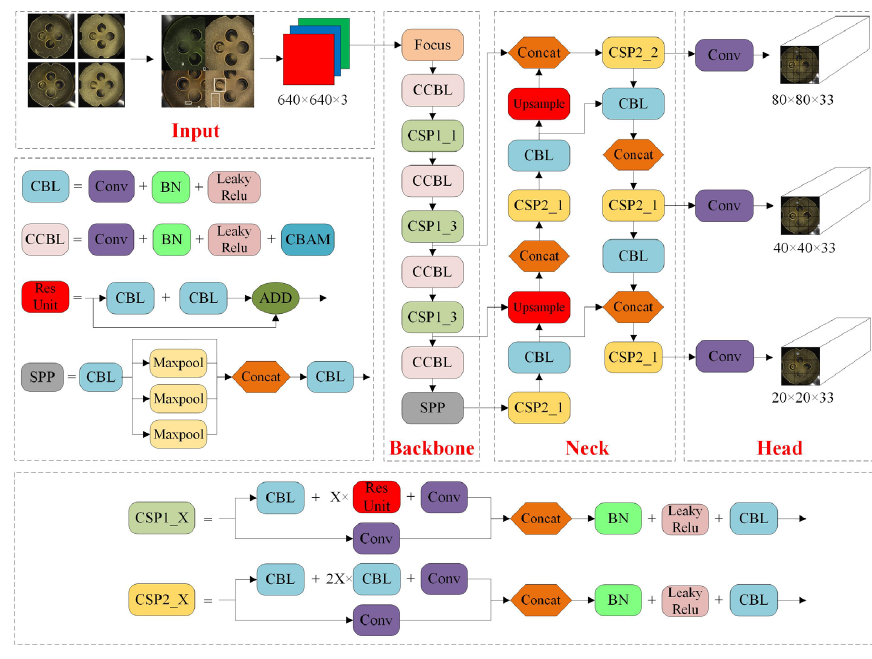
Figure 3. Structure of YOLO-V5s network.